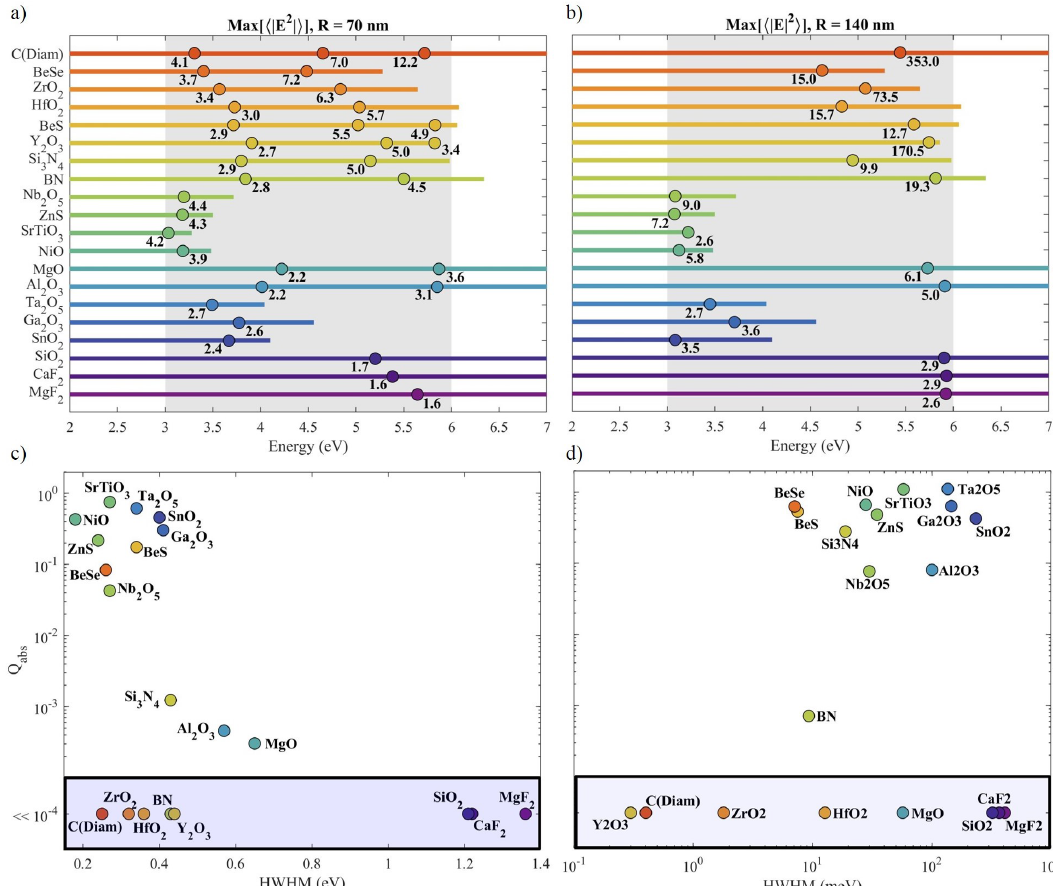
Figure 4. Summary of the (cid:104)| E | 2 (cid:105) maxima values in the [3–6] eV range for ( a ) 70 nm and ( b ) 140 nm radius spheres. For 70 nm radius, only magnetic resonances are indicated, while for 140 nm radius, only the most intense resonance is indicated. The dots indicates the energies of the maximums, while the line length indicates the range of energies where (cid:101) 2 < 0.5. Under each dot, the maximum value of (cid:104)| E | 2 (cid:105) is indicated. ( c ) Q abs vs. the HWHM of the MD resonance for a 70 nm radius sphere. ( d ) Q abs vs. the HWHM of the most intense resonance for a 140 nm radius